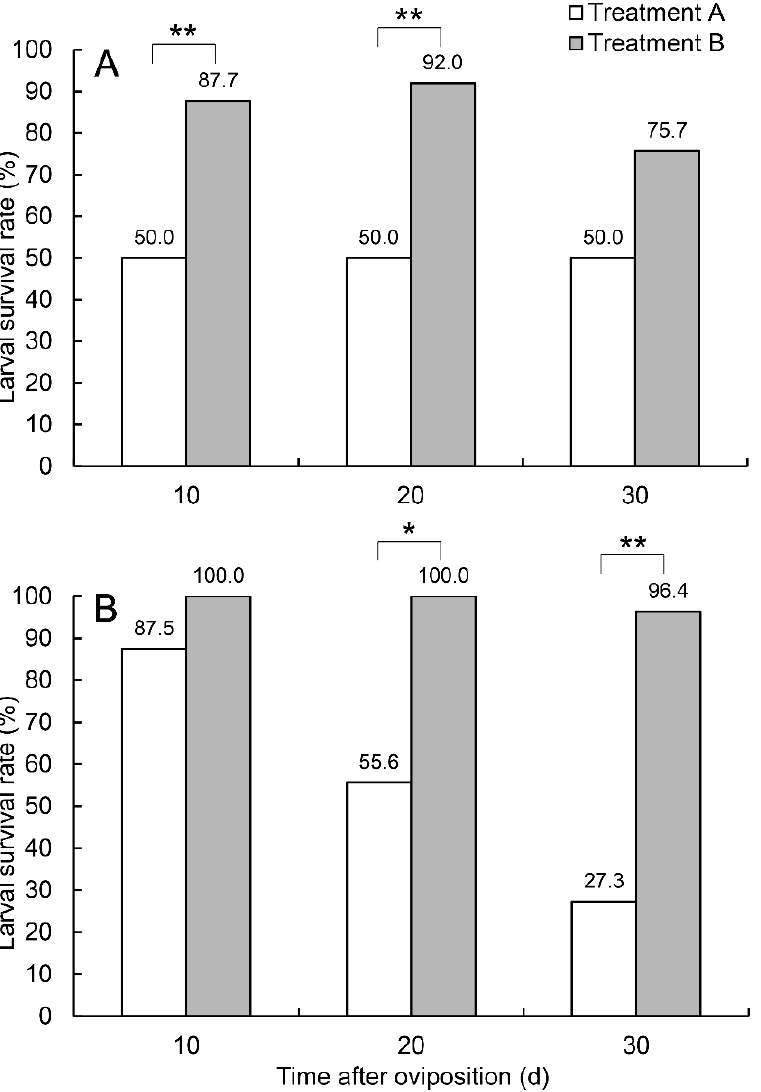
Figure 4. Larval survival rates of R. foveipennis on days 10, 20, and 30 after oviposition under treatments A and B in 2013 ( A ) and 2018 ( B ); * statistical significance at 0.05 level, ** statistical significance at 0.01 level.